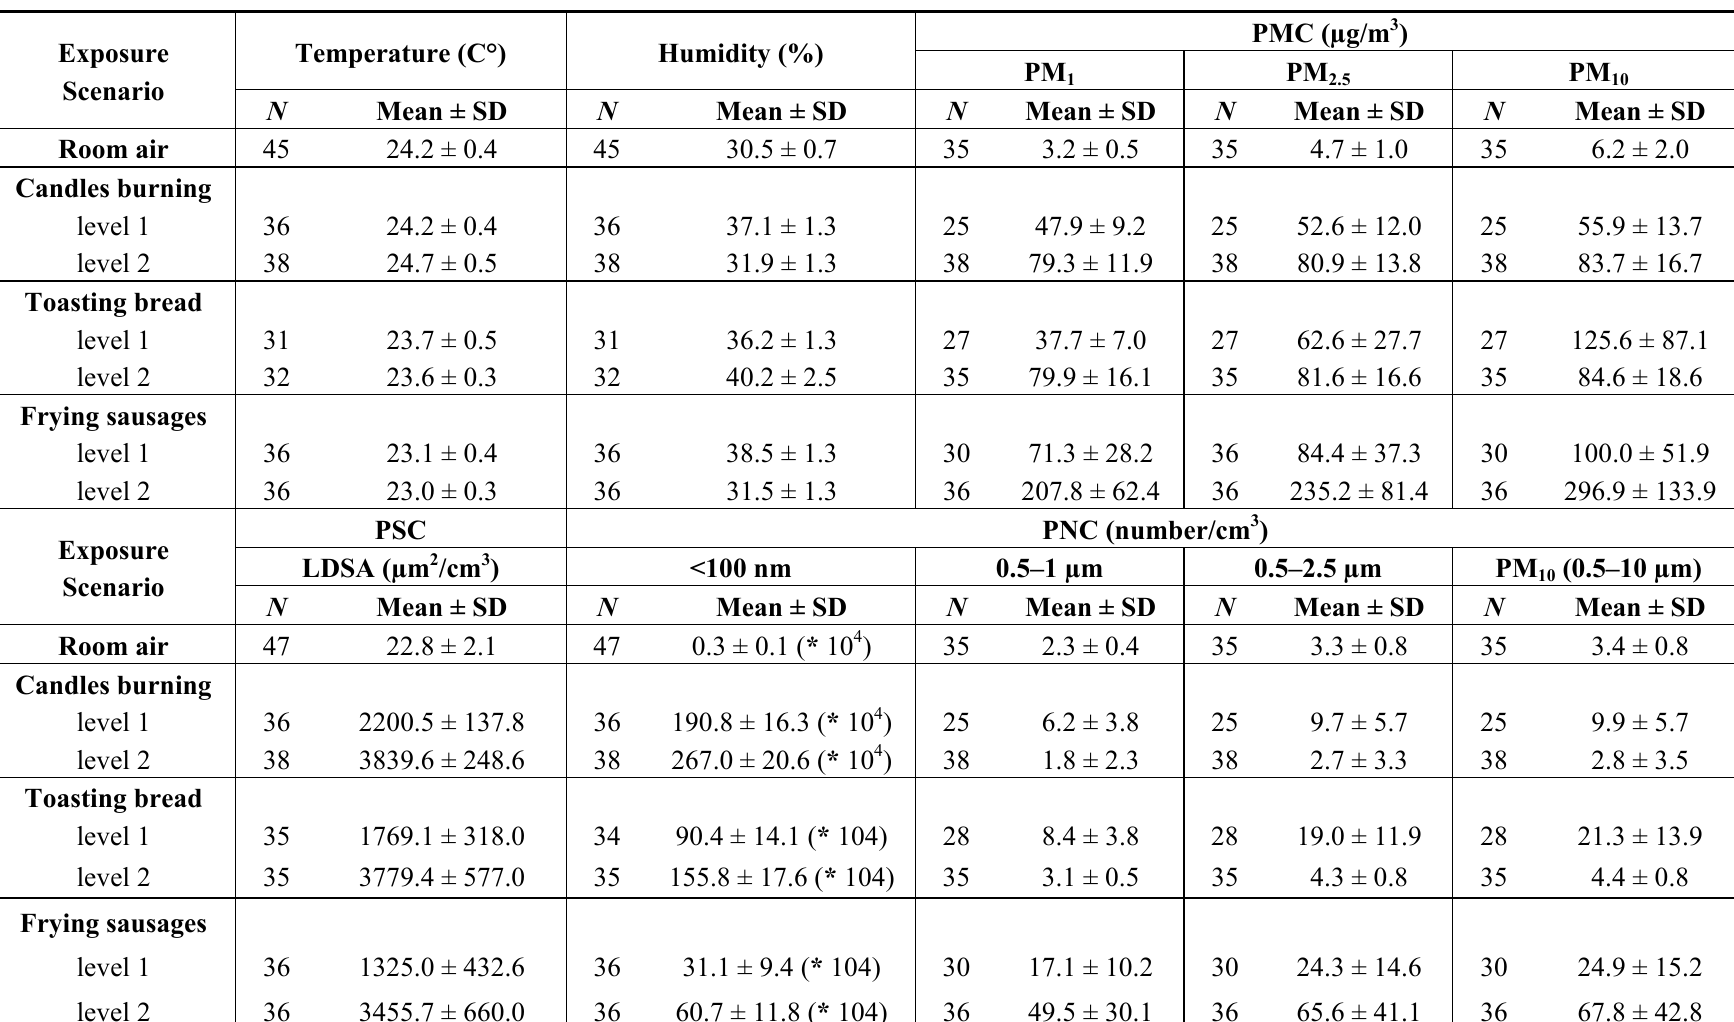
Table 2. Number of individuals exposed in each exposure scenario (N), mean and standard deviation (SD) of temperature, humidity and personal cumulative particle